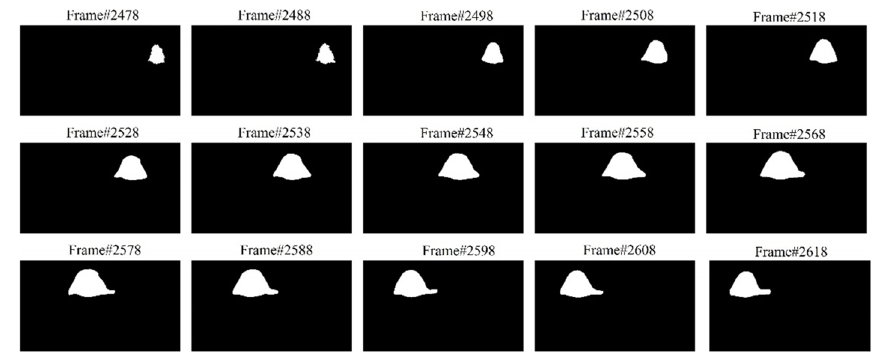
Fig. 8 UNet segmentation output for bogie part Axel across frames